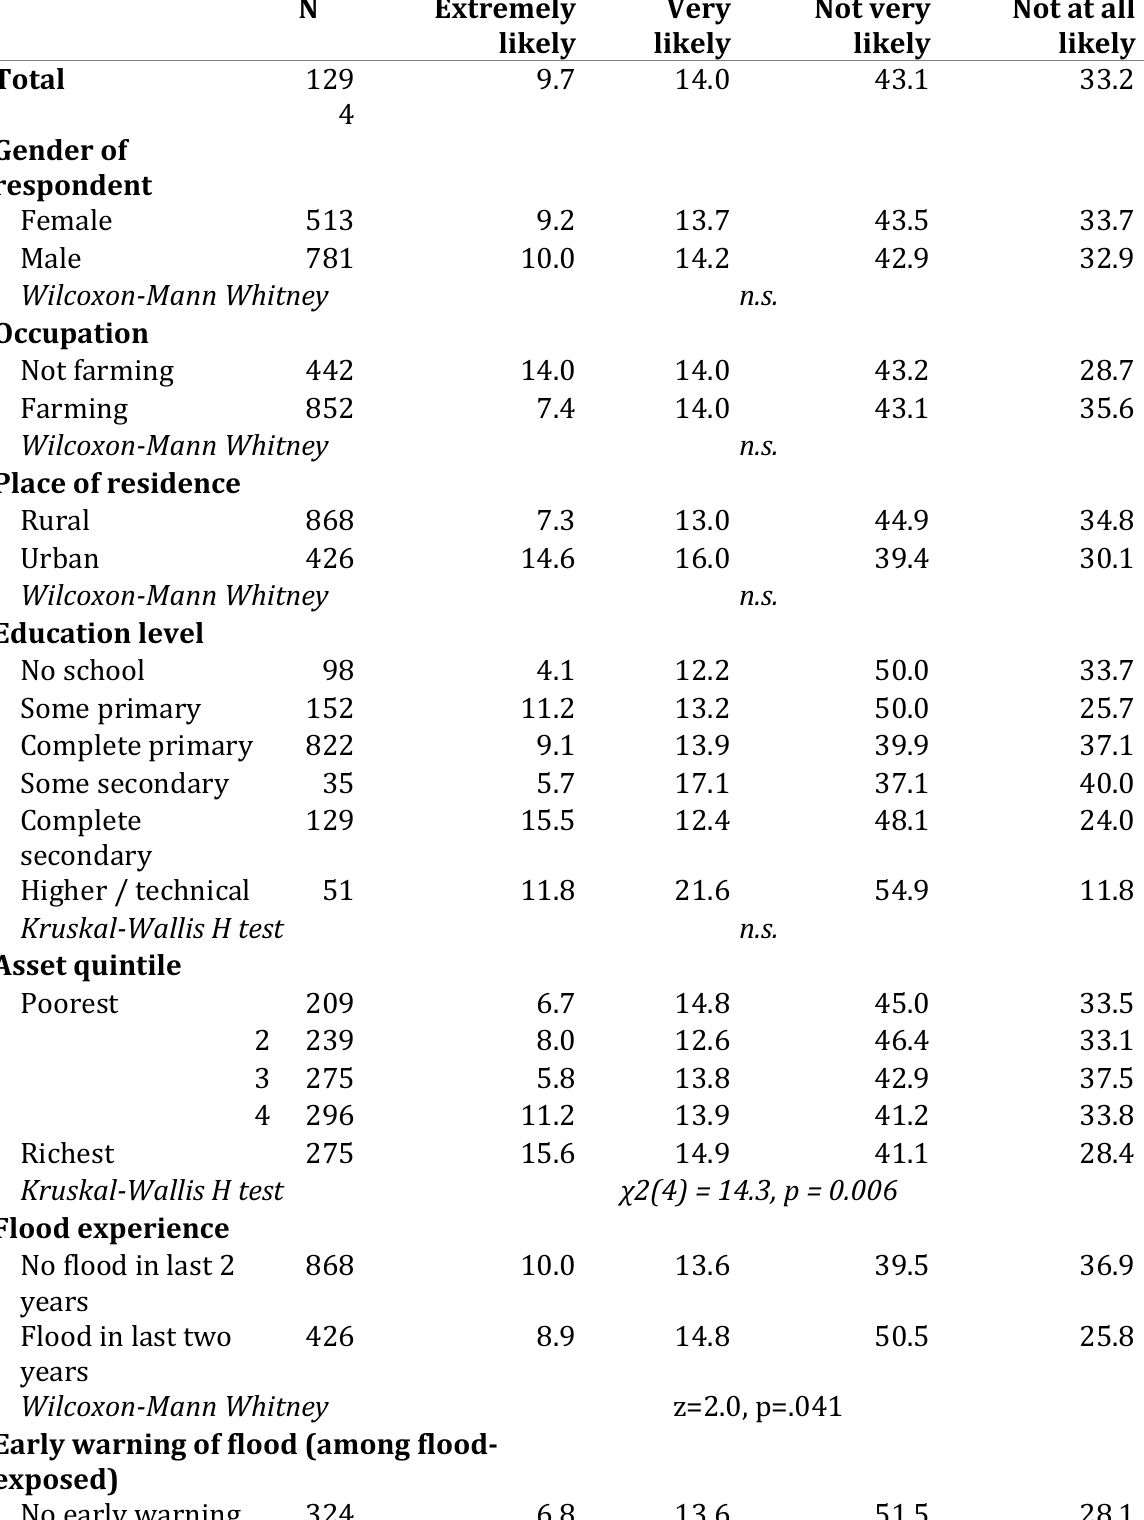
Table A1.6. Perceived capacity to change livelihood strategy by respondent